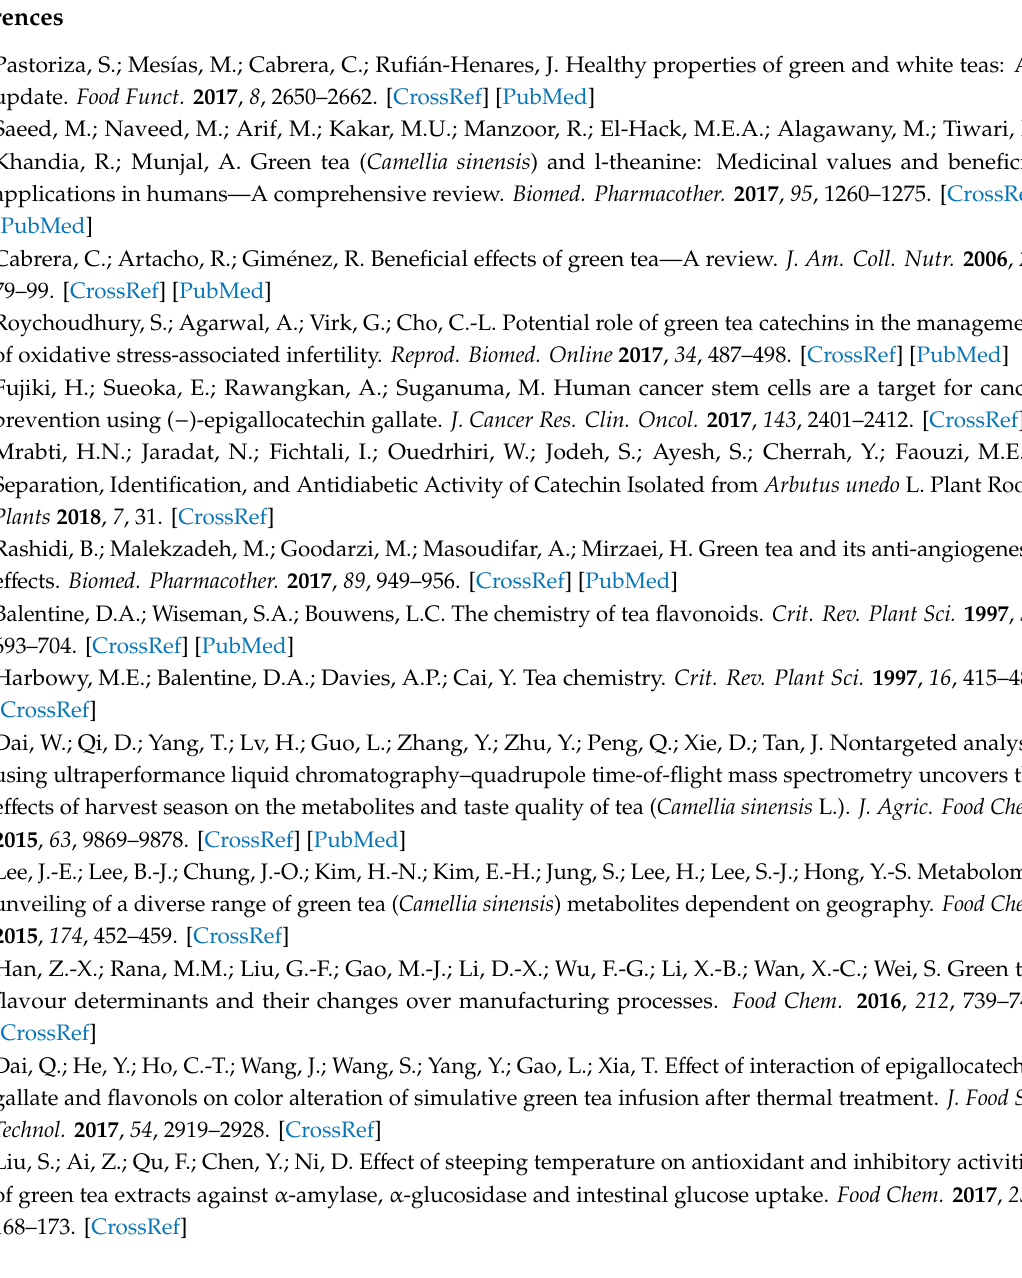
Supplementary Materials: The following are available online, Figure S1: Three-dimensional PCA score plots obtained from UHPLC-QTOF / MS analysis of green tea infusions brewed at 60 ◦ C and 95 ◦ C for 5–300 min. in positive mode (a) and negative mode (b), Figure S2: Relative intensity changes of green tea infusions brewed at 60 ◦ C and 95 ◦ C for 5–300 min, Figure S3: Representative MRM chromatograms of eight catechins at 10 µ g mL − 1 by UHPLC-QqQ / MS analysis in POS mode, Table S1: Linearity, LOD and LOQ of the developed UHPLC-QqQ / MS method, Table S2: Precision and accuracy results of the developed UHPLC-QqQ / MS